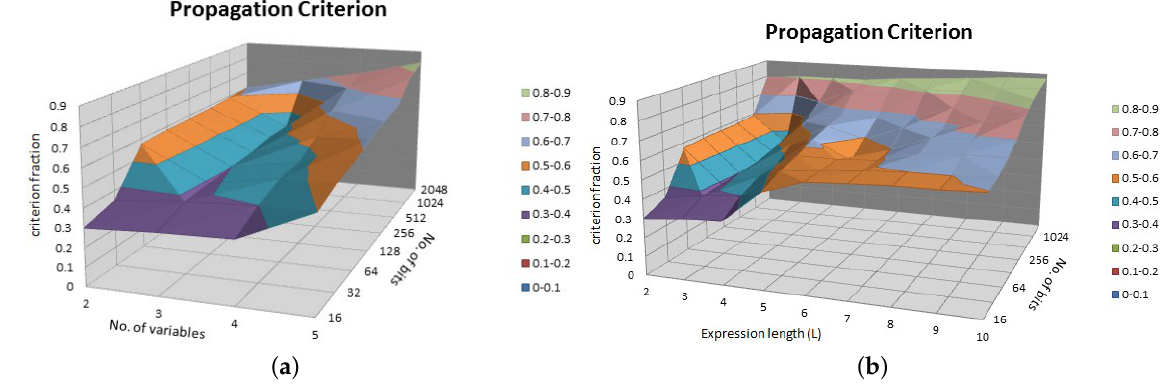
Figure 4. Propagation criterion. ( a ) Varying number of bits and variables; ( b ) Varying number of bits and expression